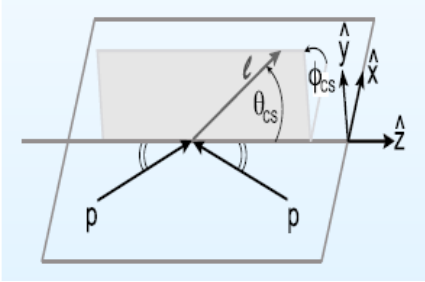
Figure 1: Angular variables in the Collins-Soper